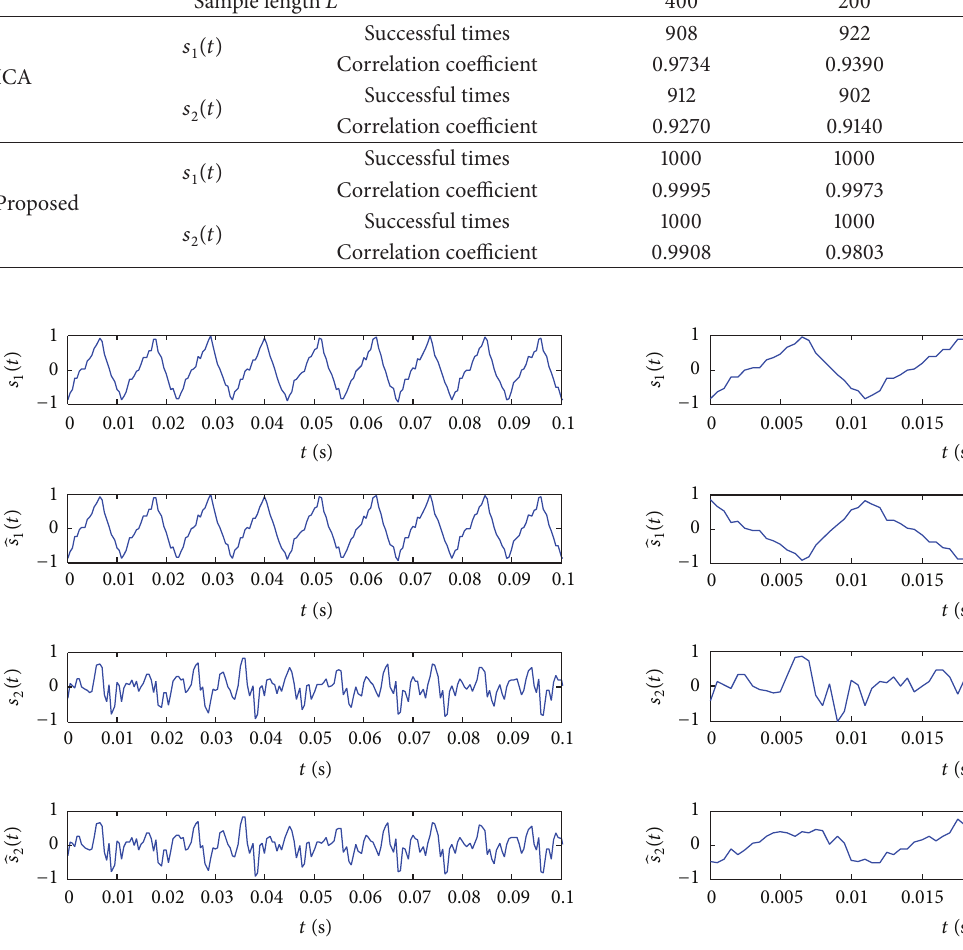
Figure 7: Practical result of fast-ICA ( 𝐿 = 70